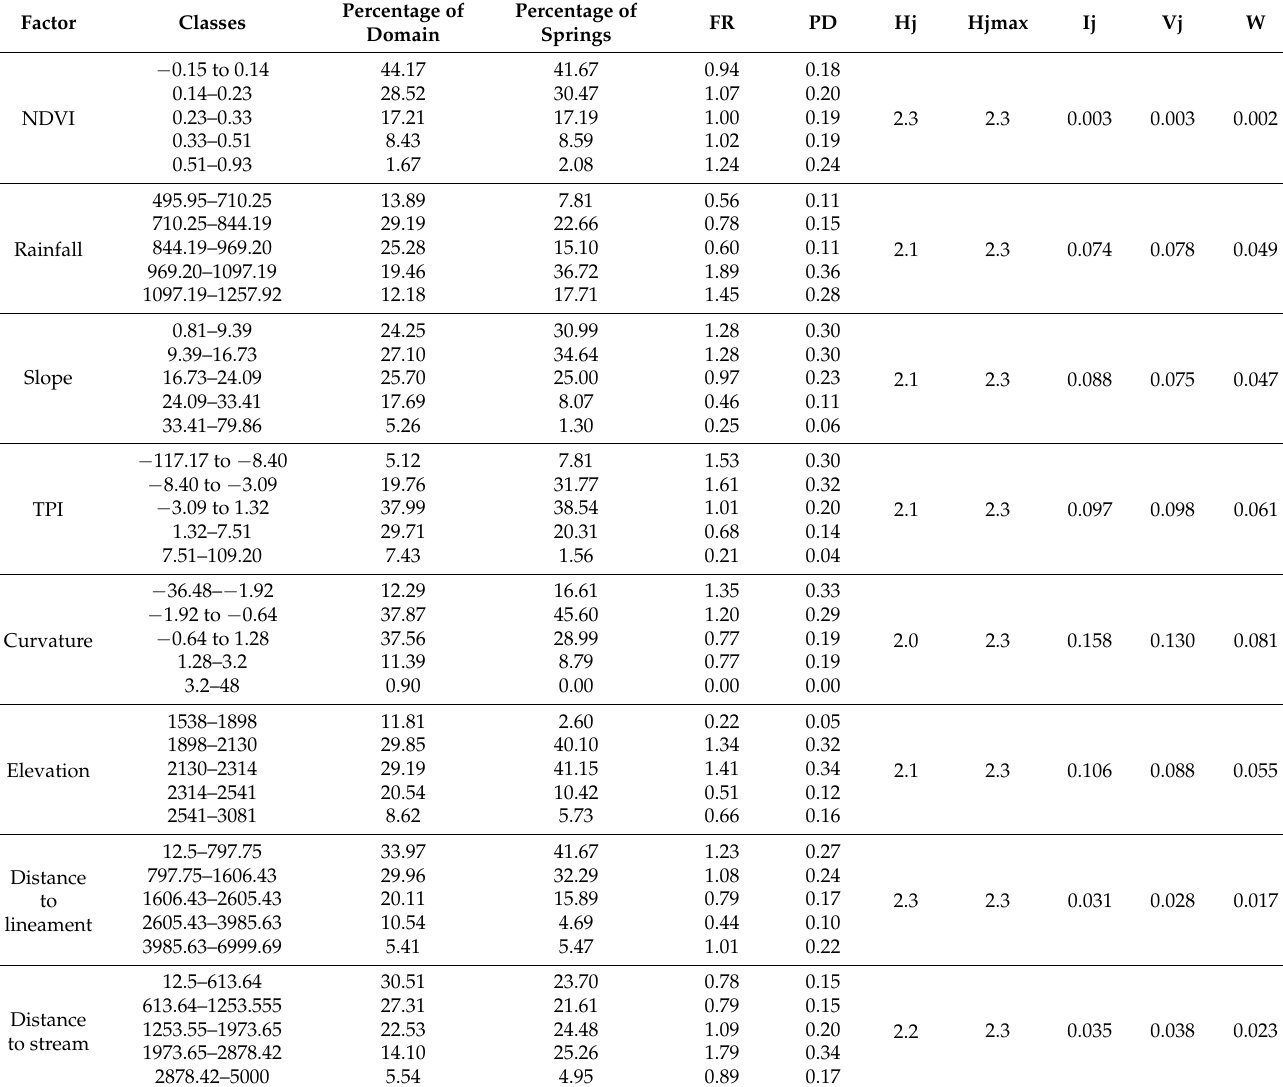
Table 3. Spatial relationships between influence factors and spring